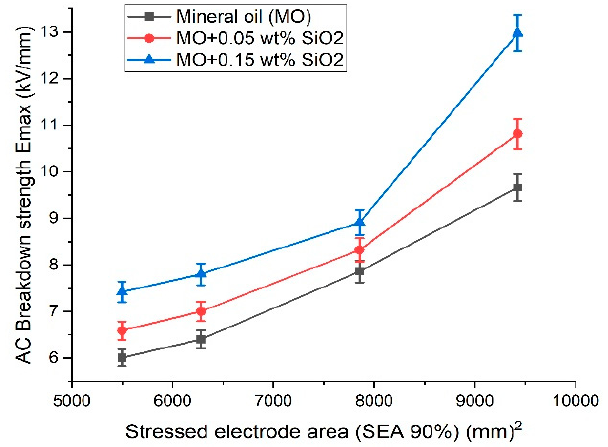
Figure 10. Graph showing the variation of maximum breakdown strength of mineral oil and its nanofluids with SEA (90%).